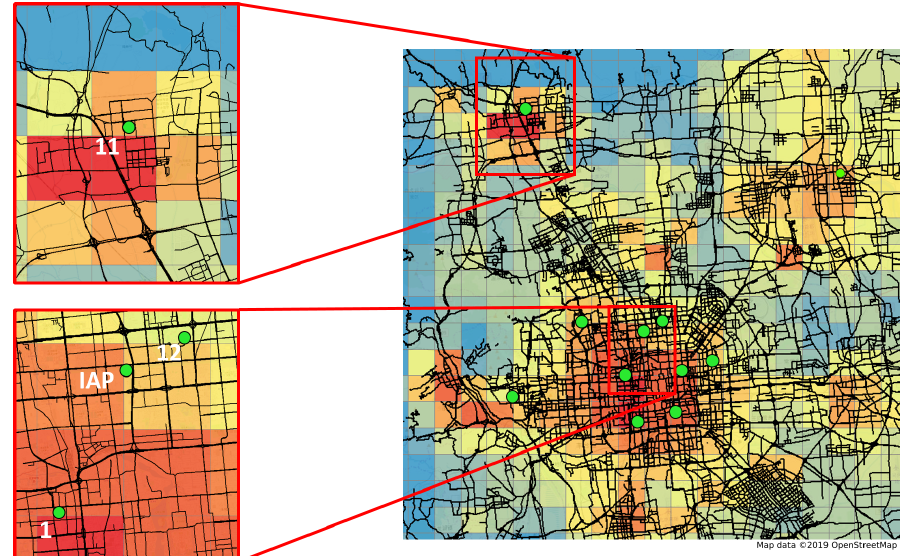
Figure 9. Spatial distribution of November and December mean MEIC Opt NO 2 emissions (all emission sectors) overlaid with Beijing road network (source: OpenStreetMap, 2019). Enlarged regions cover urban sites 1, 12 and IAP as well as suburban site 11. Right panel: © OpenStreetMap contributors 2019. Distributed under a Creative Commons BY-SA License.